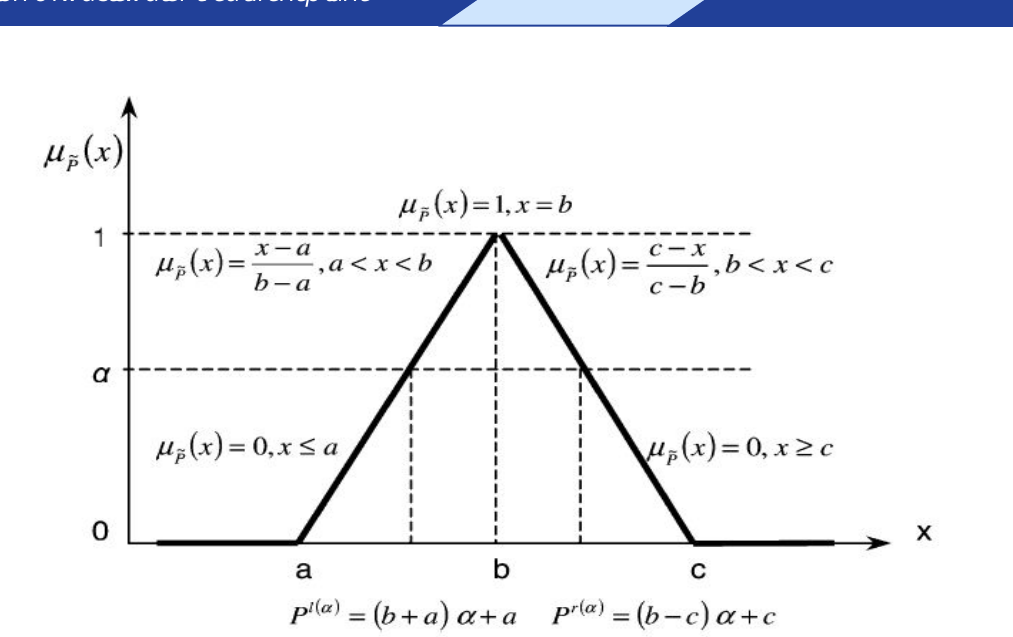
Figure 2. Left and right representation of a TFN, In this kind of fuzzy numbers, the highest probability, (a) and (c) represent the fuzziness18